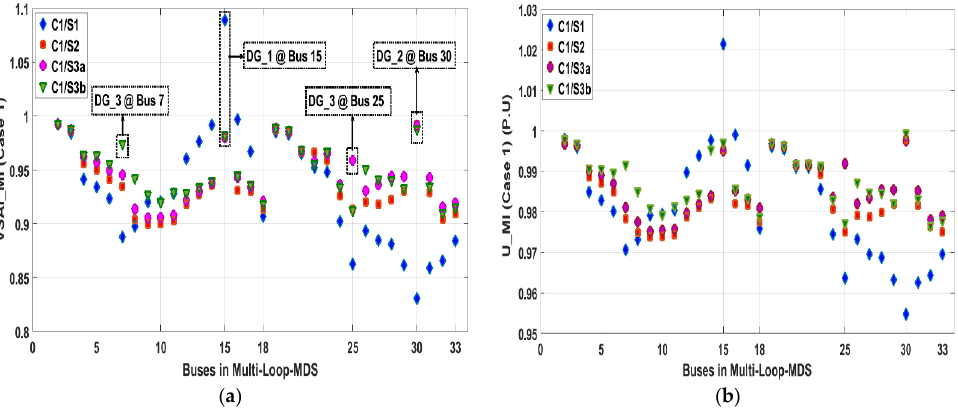
Figure 7. Case 1 for 33-bus MDS (U_Max) ( a ) VSAI trend (based on ideal MDS) for VSAI_MI-LMC; and ( b ) U-profile trend for VSAI_MI-LMC, based planning approach (DG operating @ pf = 0.9 ± 2.5%). Energies 2018 , 11 , 1213